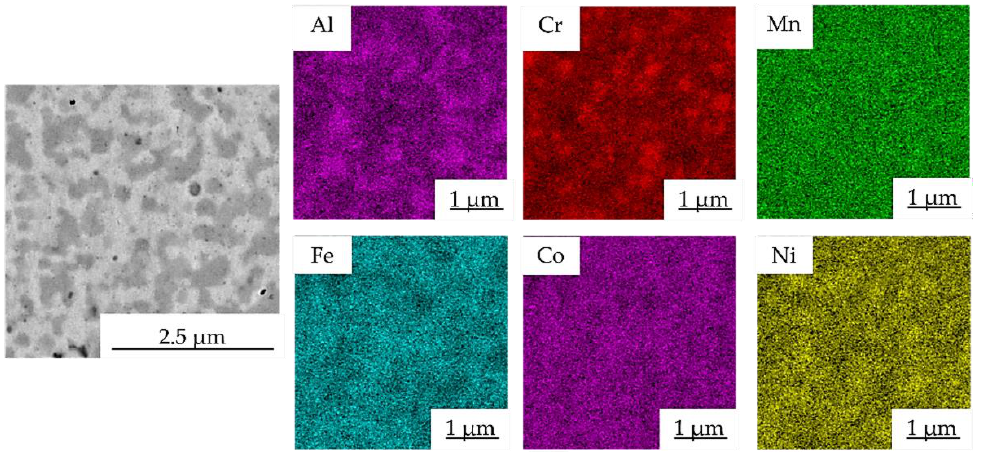
Figure 13. SEM + EDS map of element distribution in the Mn10Al10 MA + SPS compact alloy after 100 h annealing at 800 °C.